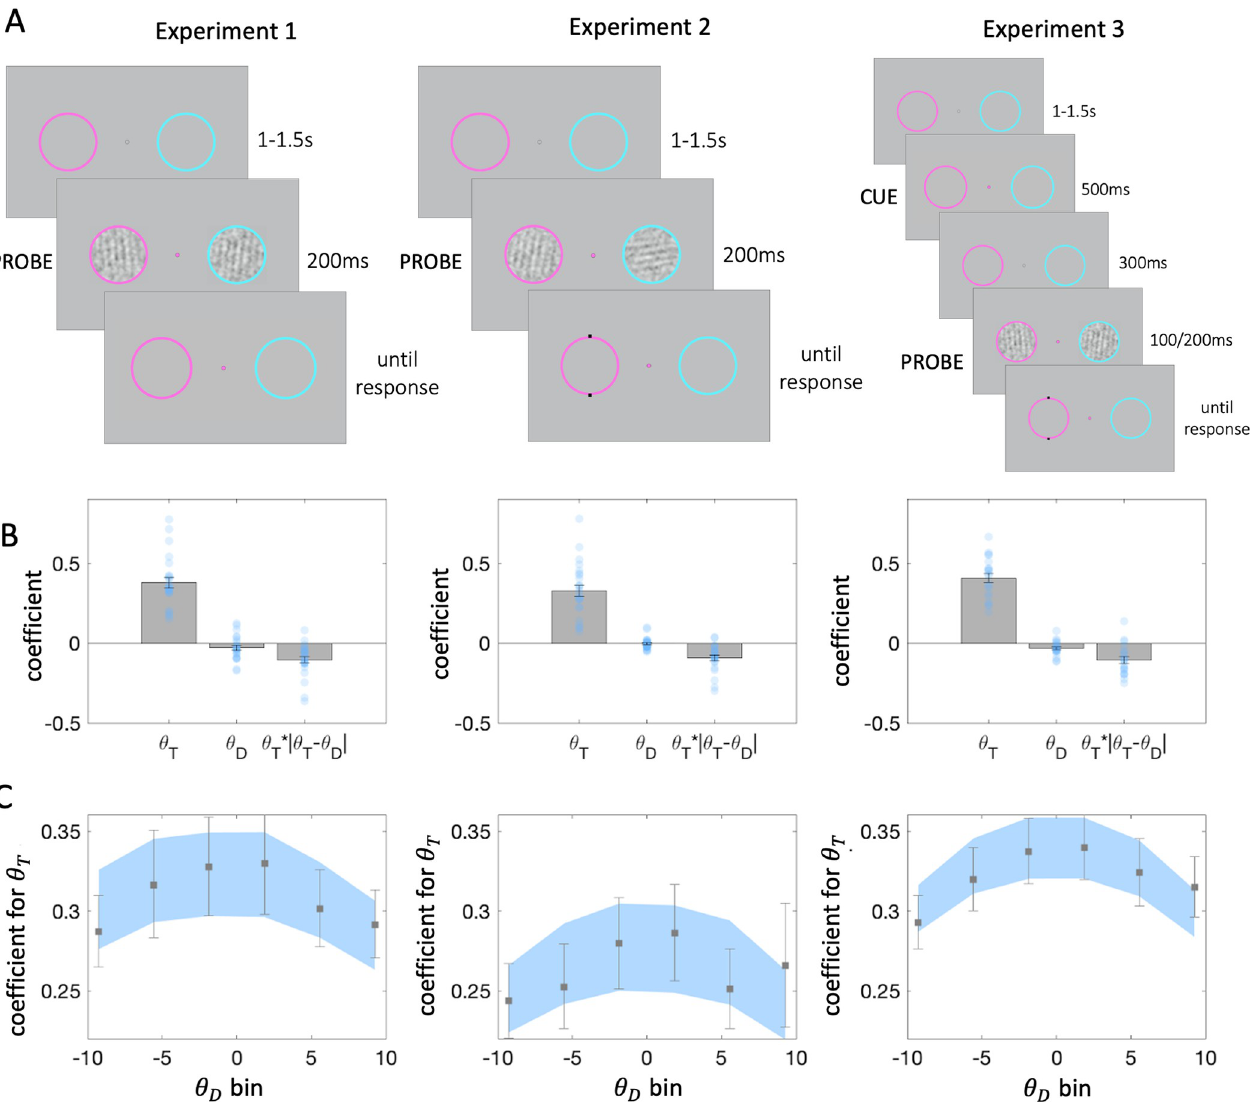
Fig 1. A. Experimental design. Left : Participants were asked to fixate on a point in the centre of the screen. Two noisy gratings appeared briefly within the coloured rings on the left and right of the fixation point. At stimulus onset, the fixation point changed colour and served as a probe. Participants had to report the tilt (CW or CCW) of the probed grating relative to vertical. Middle : In experiment 2, the two coloured rings had different reference orientations. In the example here, the decision boundary for the pink ring was vertical, and horizontal for the cyan ring. Right : In experiment 3, 800ms prior to stimulus presentation, the fixation point assumed the colour of the ring which was more likely to be probed (70% validity) for 500ms. B. Beta coefficients from regression of choices on target and distracter orientation. Note that the θ T � | θ T - θ D | interaction term is divided by 10, to ensure that unit changes in each predictor variable are reported in consistent terms. Grey bars denote averages, error bars denote standard error of the mean, blue dots represent individual participants (Exp.1, n = 24; Exp.2, n = 24; Exp.3 = 20). C. Distracter orientation was divided in 6 equally spaced bins. Within each bin we estimated a binomial regression of choices on target orientation ( β 1 only). Grey squares denote regression with human choice as the outcome variable, and error bars denote standard error of the mean. Blue region denotes standard error from the same regression, but with choice estimates derived from Eq 4 fit to human